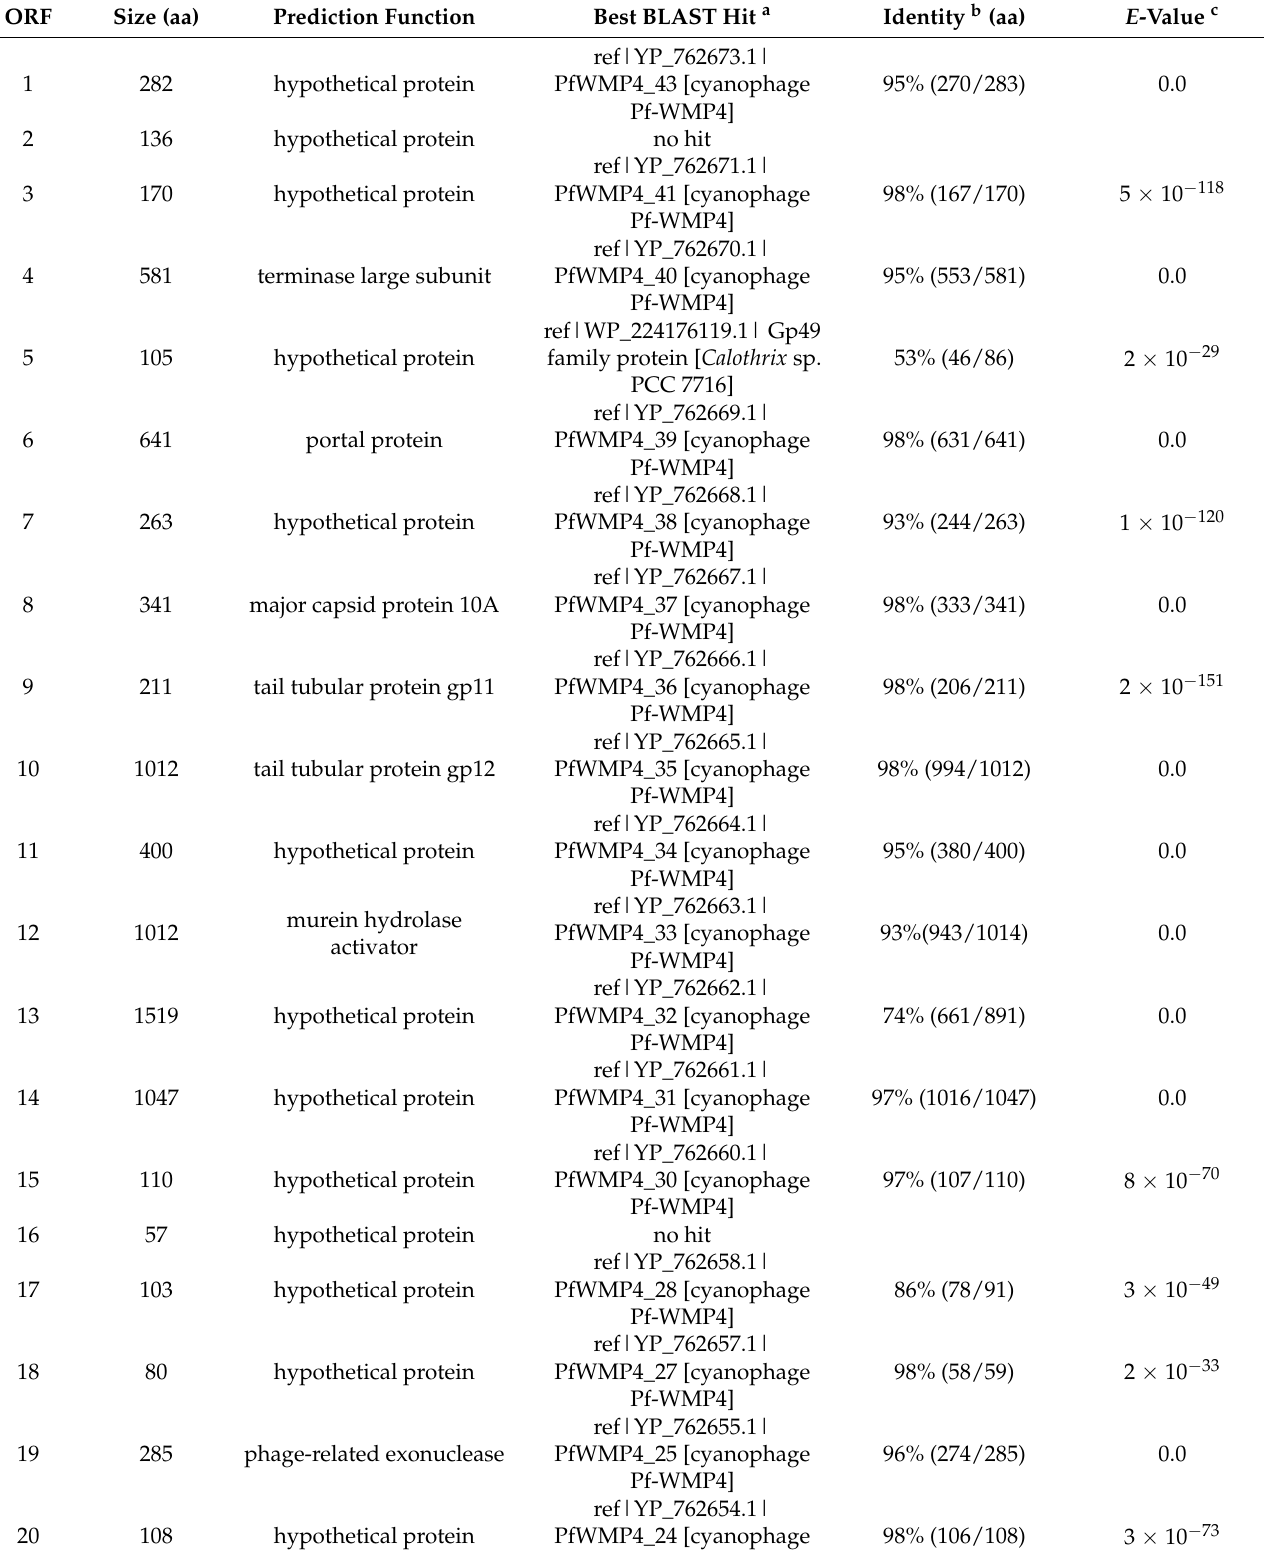
Table 2. ORF analysis of cyanophage